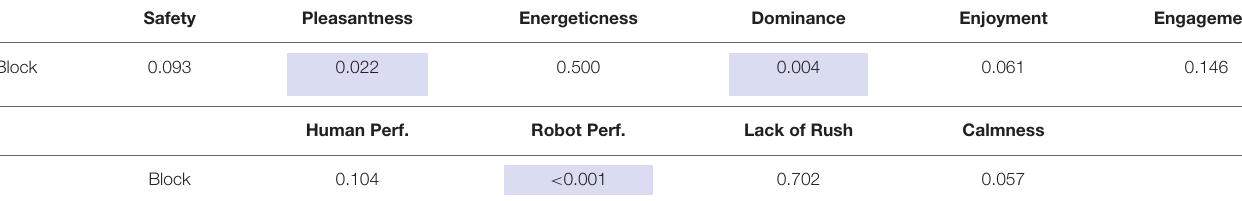
TABLE 2 | p -values for the one-way rANOVA run to determine the effects of the block conditions. Safety